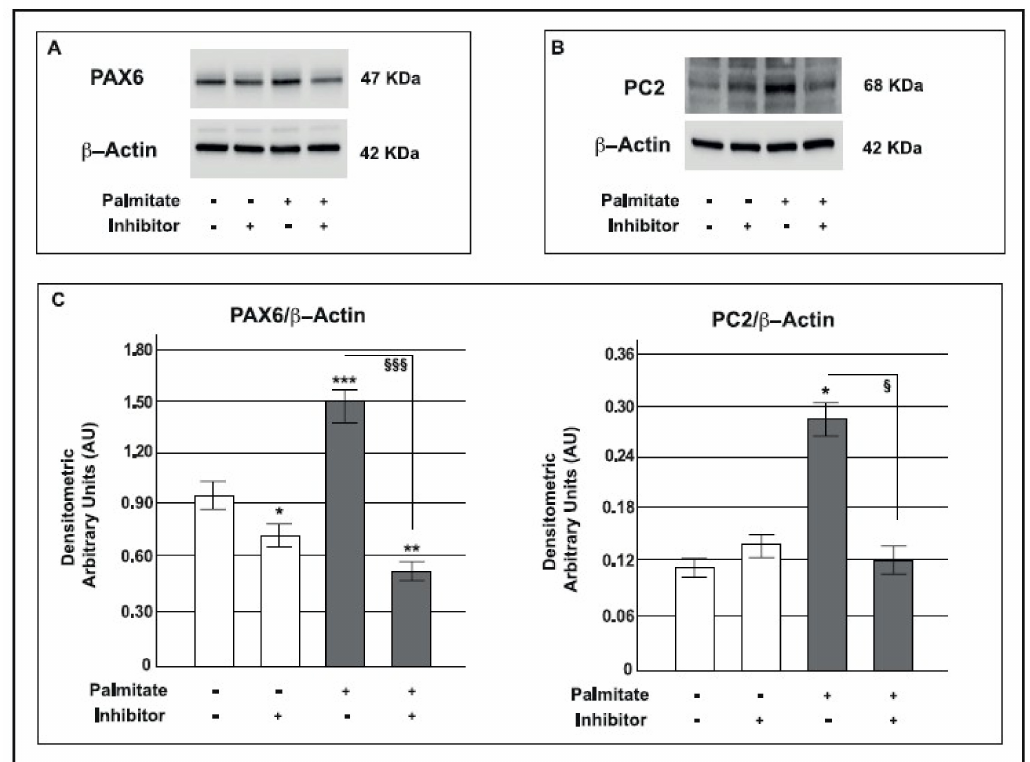
Figure 9. Effects of MAPK pathway inhibition on PAX6 and PC2 protein expression in GLUTag cells pre-exposed to palmitate. Representative Western blot from control and palmitate GLUTag treated cells (0.5 mM for 24 h) in the absence or presence of U0126 (MAPK Inhibitor) for: A : PAX6 and β -actin; B : PC2 and β -actin; C : corresponding densitometric analysis in control cells (open bars) and in cells exposed to palmitate (gray bars). * p < 0.05, ** p < 0.01, *** p < 0.001 vs. control; § p < 0.05, §§§ p < 0.001 vs. palmitate (1-way ANOVA followed by Bonferroni test, n = 3); (+) means presence, (-) means